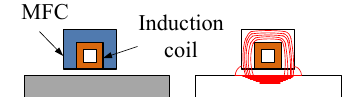
Figure 3. Section of the Induction coil and magnetic flux concentrator (MFC).